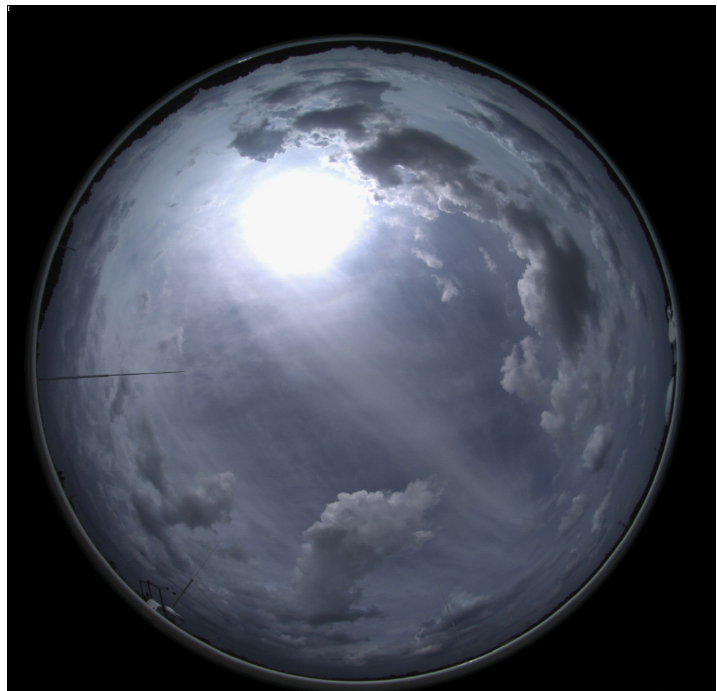
Figure B3. Sky image taken by ASI UOL, representing a multi-cloud-layer situation on 6 August 2019 12:35.